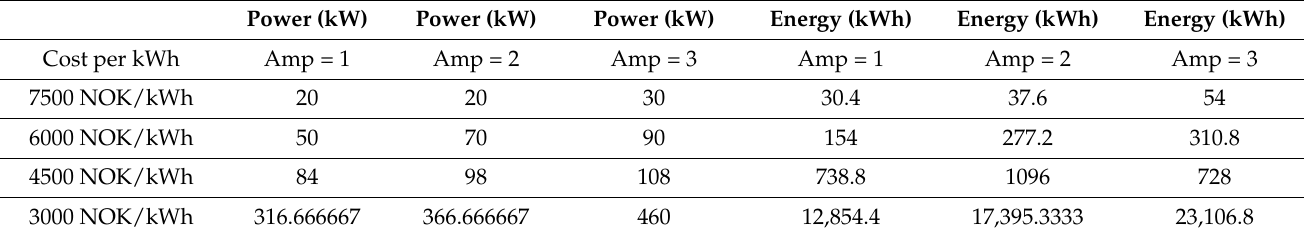
Table 2. Battery unit cost versus the possibility to match power and energy requirements at the INSPIRIA charging stations—used as input to Figures 7 and 8. Increasing demand, as represented by amplification factors 2 and 3, has been considered.